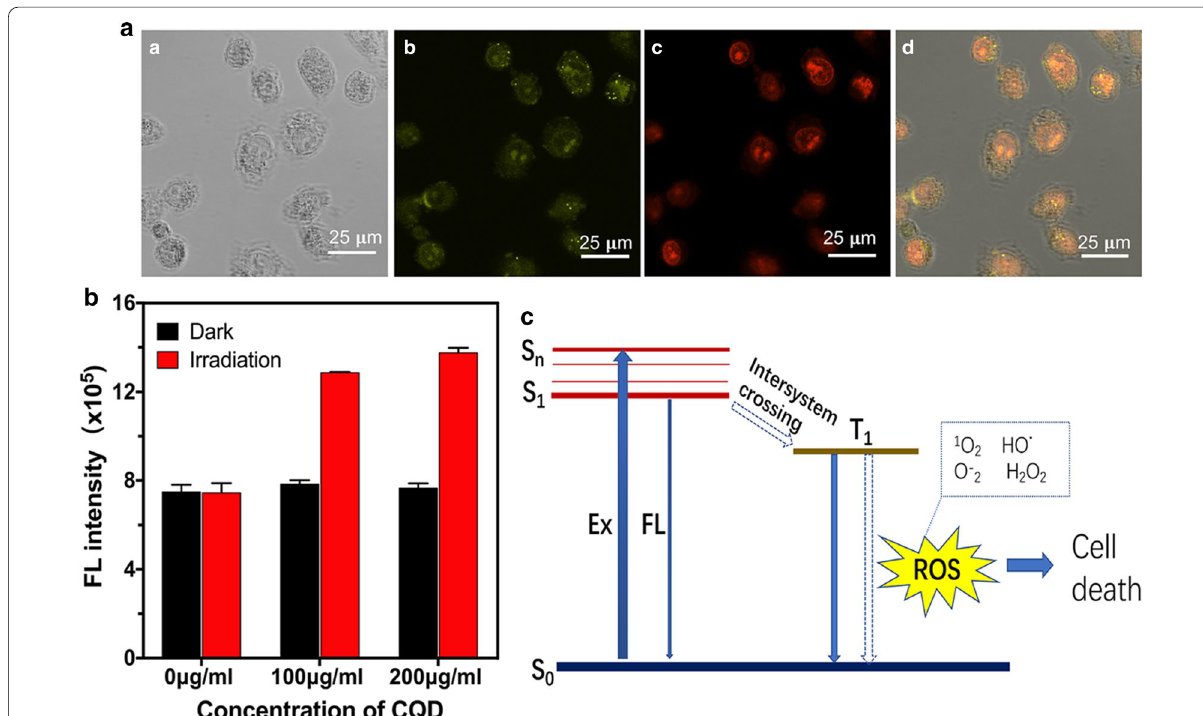
Fig. 4 Intracellular ROS generation. A Fluorescence images of HeLa, (a) Bright field transmission image, (b) CQDs fluorescence image collected in the range of 400–450 nm, (c) ROS detection reagent fluorescence image captured in the range of 510–530 nm, and (d) the merged image; B The intracellular ROS production for various concentrations of CQDs with or without irradiation for 15 min; C a simplified energy level diagram shows potential fluorescence and cell death energy transfer pathways. (S0, ground state of the fluorophore molecule; S1, first singlet excited state; Sn ( n > 1); T1, first triplet excited state; Ex, excitation by photon absorption; FL,